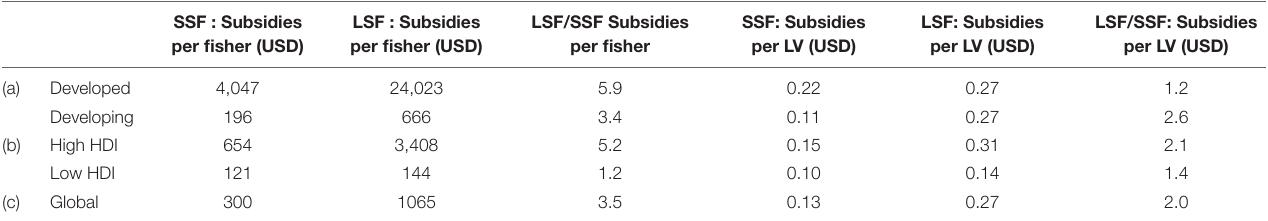
FIGURE 5 | Global fisheries subsidies (2018 constant USD) presented for small- and large-scale fisheries by subsidy category and grouped by (A) developed and developing countries and (B) High and Low HDI groups. TABLE 1 | Global fisheries subsidies (2018 constant USD) and subsidy intensity (SI; subsidy amount per number of fishers and per total landed value) per (a) Developed and Developing nations, (b) High and Low HDI countries and (c) globally, split into small- (SSF) and large-scale fisheries